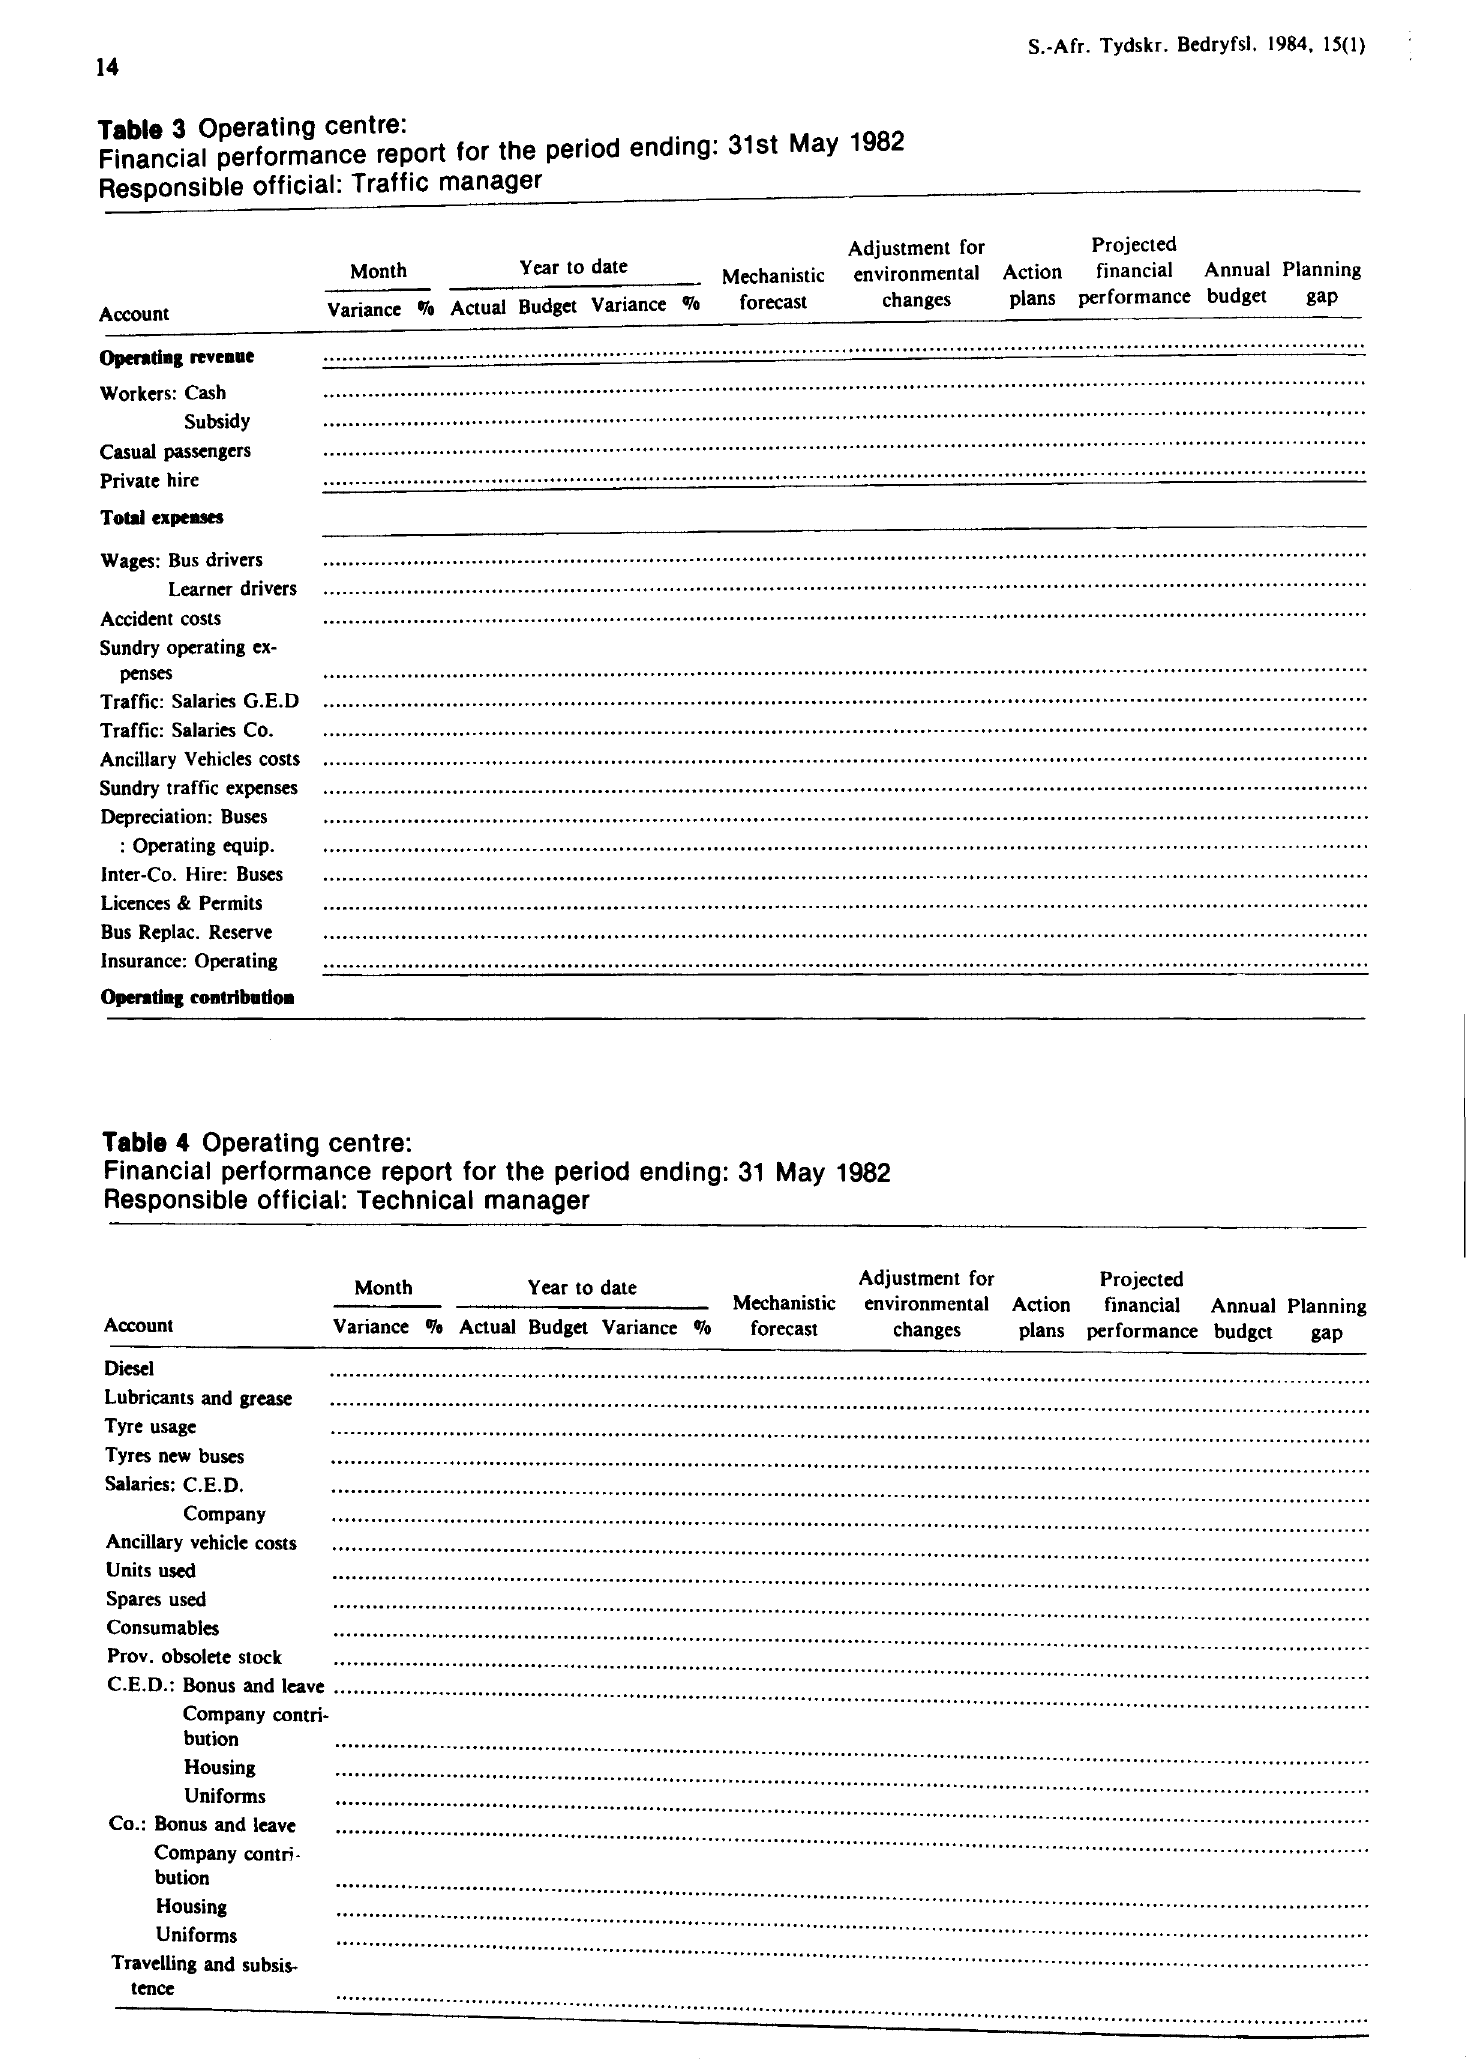
Table 3 Operating centre: . .